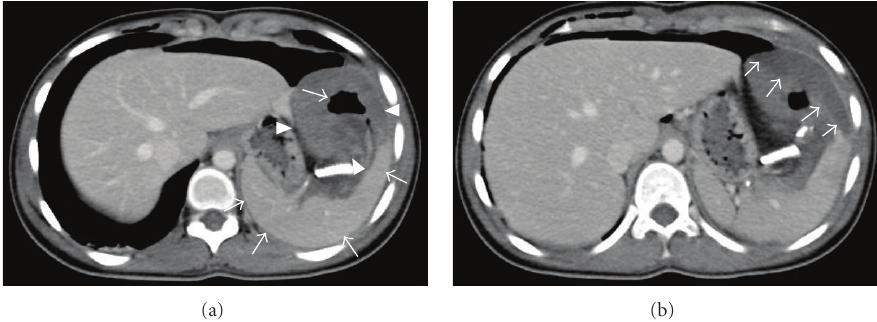
Figure 5: (a, b) Axial enhanced CT postsurgical decapsulation of the splenic cyst (3rd post-operative day) reveals an intact and homogeneously enhanced splenic parenchyma (a). The hypodense area at the anatomic region of the decapsulated cyst anterior to the spleen (a) that contains loculation of air in its center (a) represents the remnants of the cystic wall that have partially collapsed after laparoscopic surgical decapsulation together with perisplenic pockets of fluid (b).